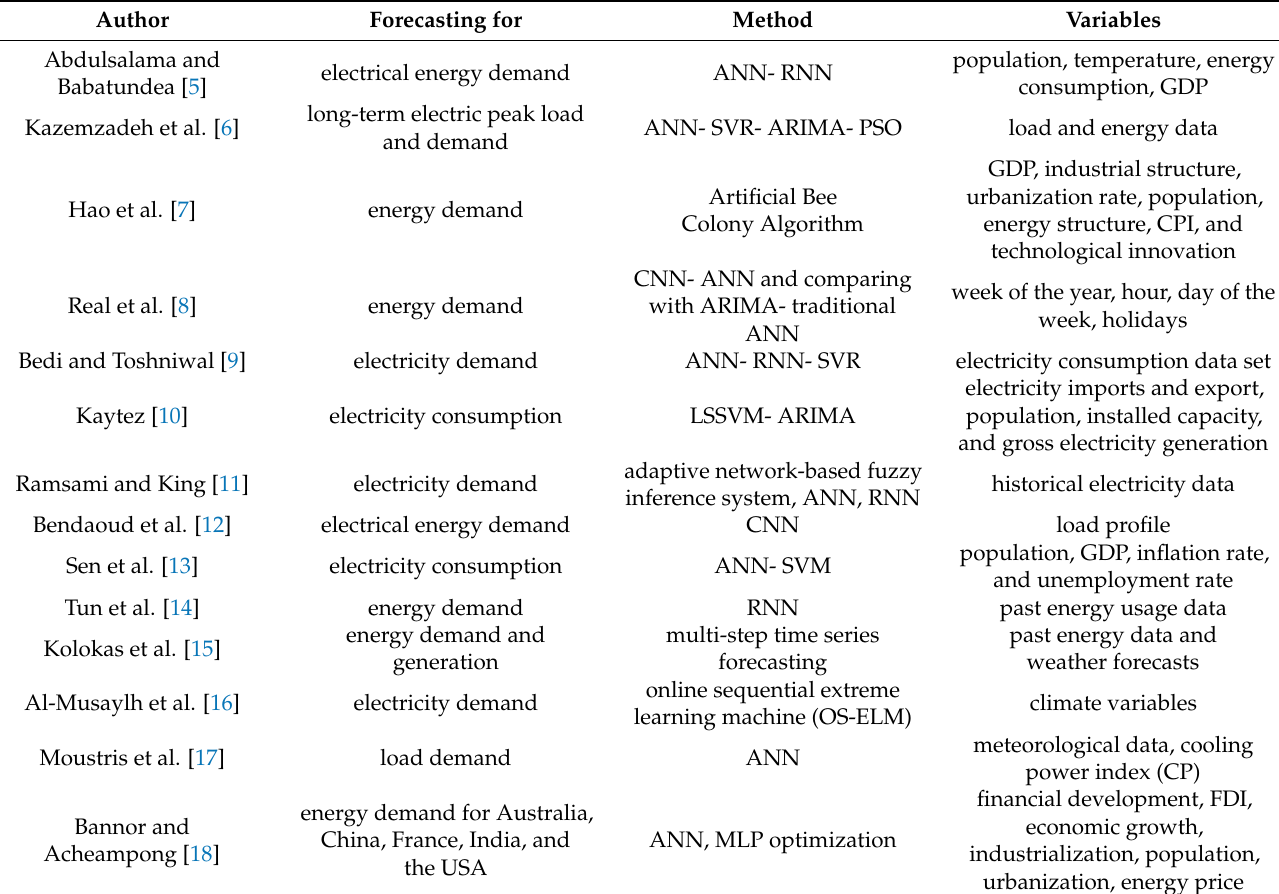
Table 1. Electricity demand and consumption forecasting studies in the